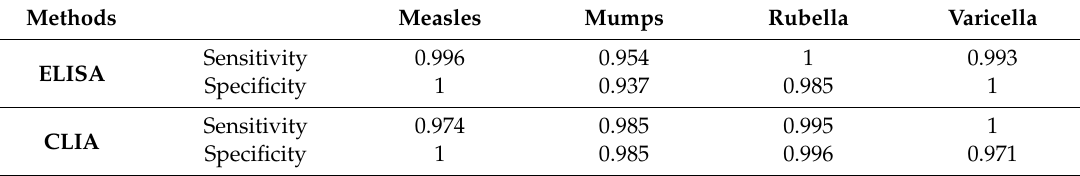
Table 4. Sensitivity and specificity of the serology